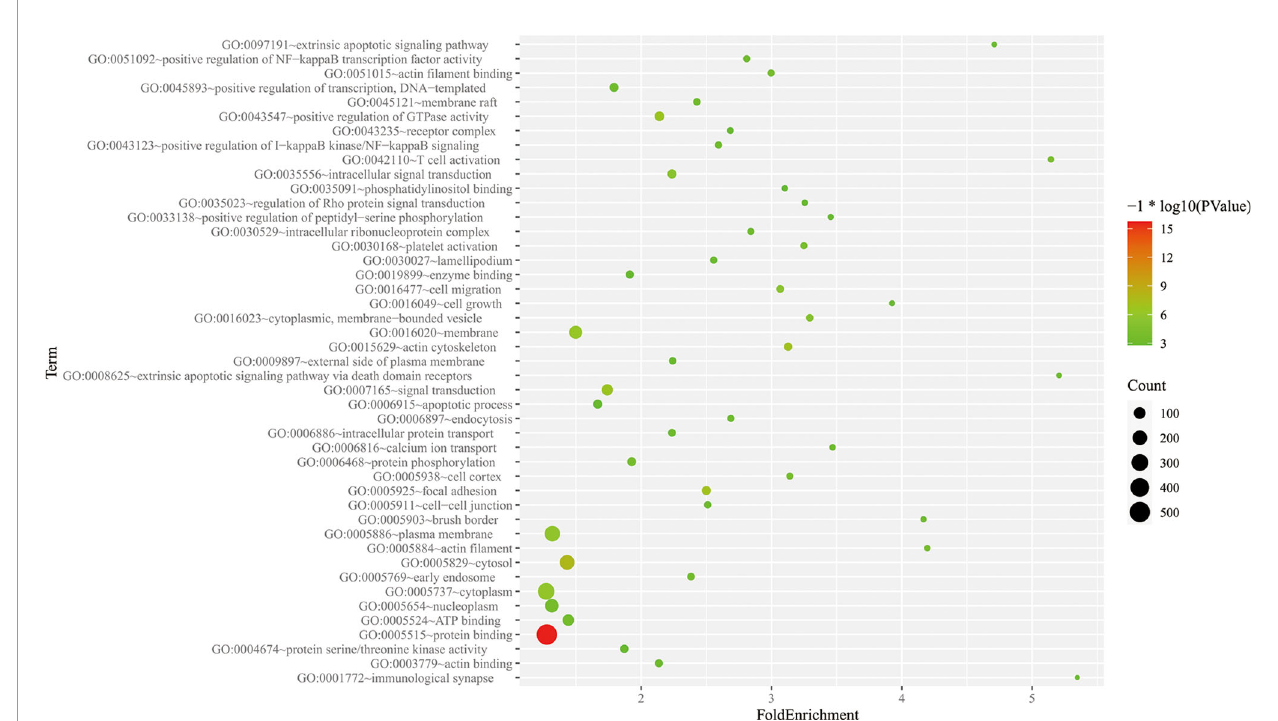
FIGURE 7 | Partial GO pathway enrichment analysis bubble chart. The vertical axis indicates the name of the GO pathway, the horizontal axis is the enrichment factor, and the size of the circle indicates the number of differential methylation-related genes involved in the pathway, The color response of each channel takes p value of – log10.